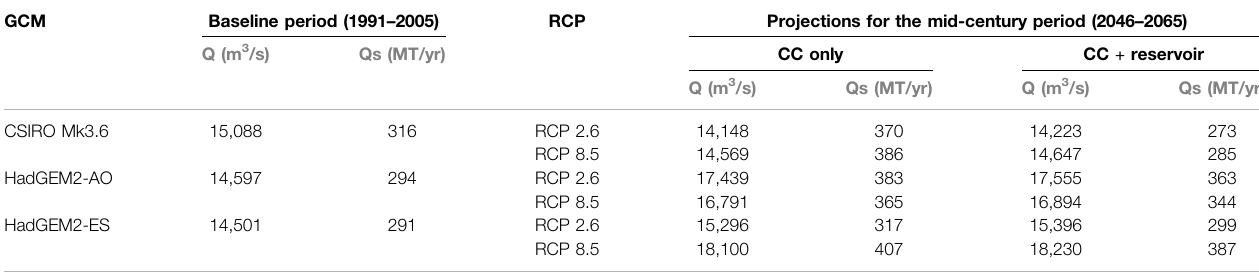
TABLE6| Projectedmeanannualstream fl owandsedimentloadsatPyayfromthethreeGCMsforthebaselineperiod(1991 – 2005)andmid-centuryperiod(2046 – 2065).Q is stream fl ow and Qs is sediment load. CC denotes climate change.